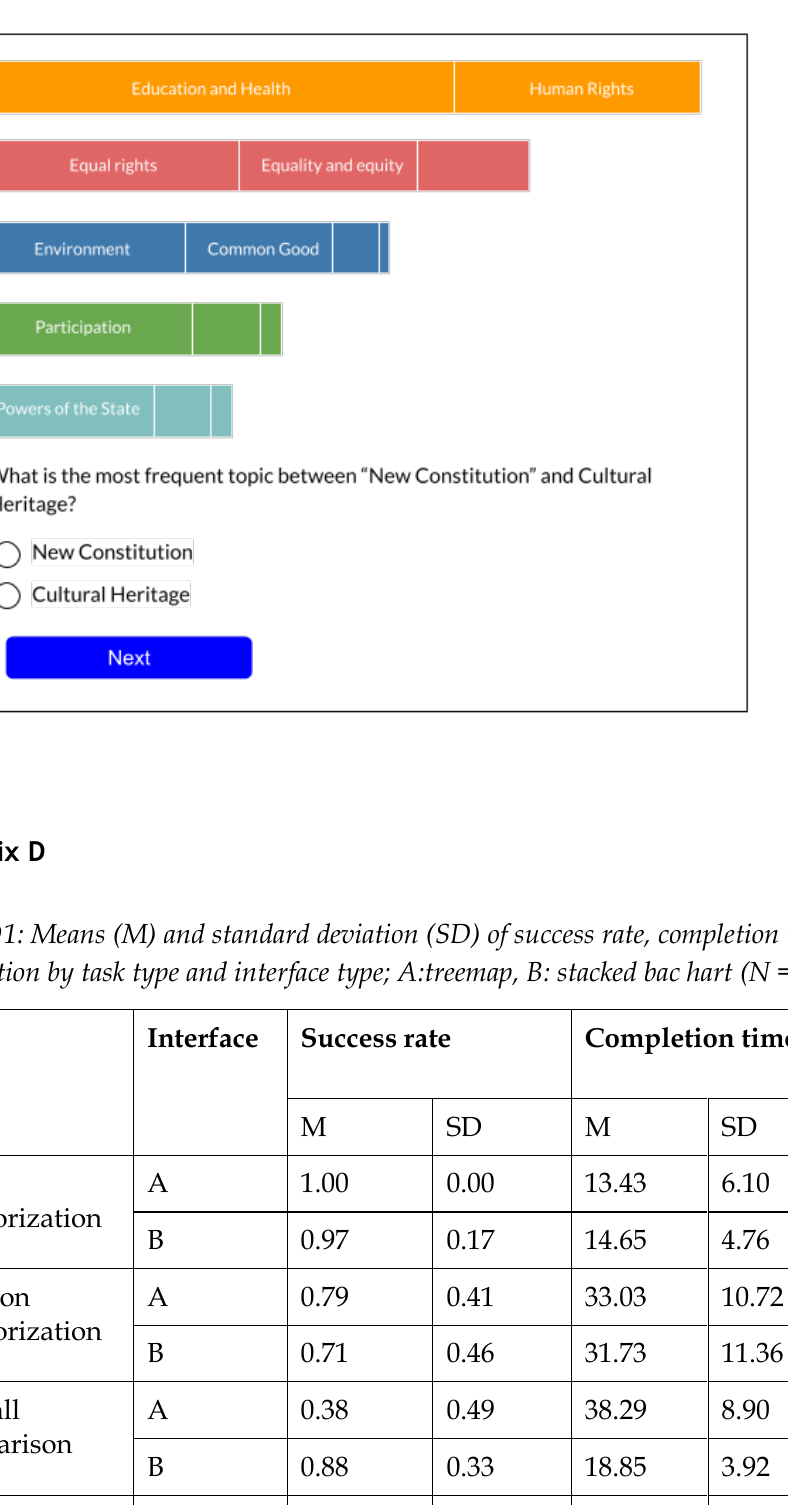
Figure C2: Example of an overall categorization task